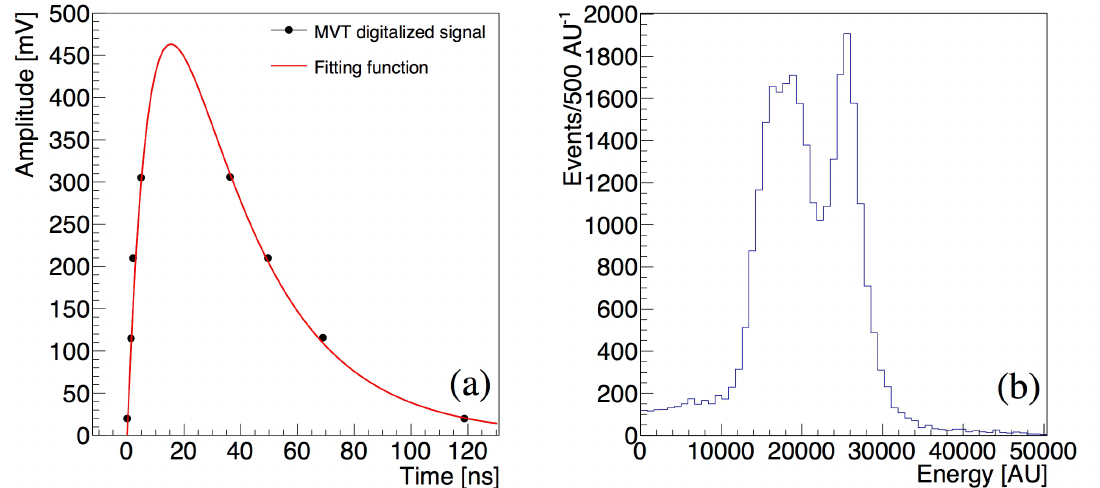
Figure 6. Response of a LYSO/SIPM channel after the detection of a 511 keV photon from a 22 Na source. In ( a ) the MVT digitized signal (black points) and the fitted function reconstructing the original signal (red line) are shown. The fitted function is integrated within a time window of 200 ns and the distribution of its integral for a small sub-sample of 30,000 events is shown in ( b ): the photoelectric peak and the Compton continuum are visible in the obtained spectrum.